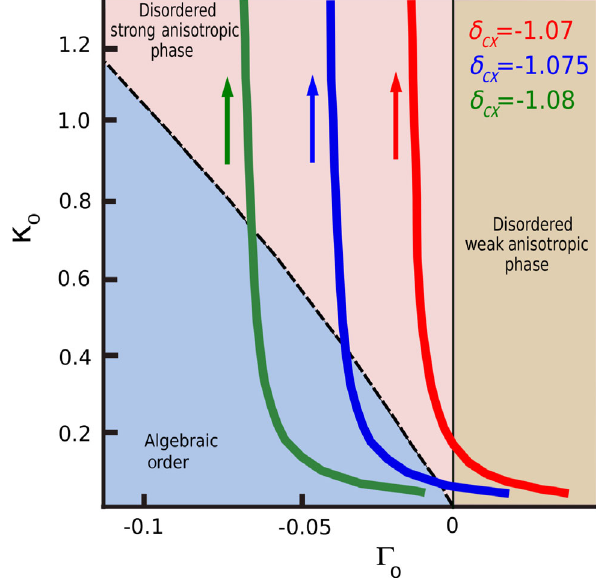
FIG. 3. Crossover between nonequilibrium and equilibrium- like universal regimes. We show stable three-mode OPO con- figurations in the Γ 0 − κ 0 space for three different detunings, δ − 1 . 07 (green line), − 1 . 075 (blue line), − 1 . 08 (red line), CX ¼ 1 . 4 and k 0 . 1 (region A in Fig. 2). The arrows and for k p ¼ s ¼ indicate the direction of the increasing external drive strength. The dashed line shows the BKT phase boundary [see Eq. (25)] between algebraically ordered and disordered phases. By in- − 1 . 07 , we cross creasing the external pump power, for δ CX ¼ from the nonequilibrium (WA) to the equilibrium-like (SA) − 1 . 075 , the systems shows disordered regimes. For δ CX ¼ reentrance; it starts in the WA, enters the SA algebraically ordered regime, and finally goes back to the disordered but − 1 . 08 , we are in the SA equilibrium- now SA regime. For δ CX ¼ like regime for all pump powers, and the system undergoes a BKT transition from an algebraically ordered to a disordered phase by increasing F p